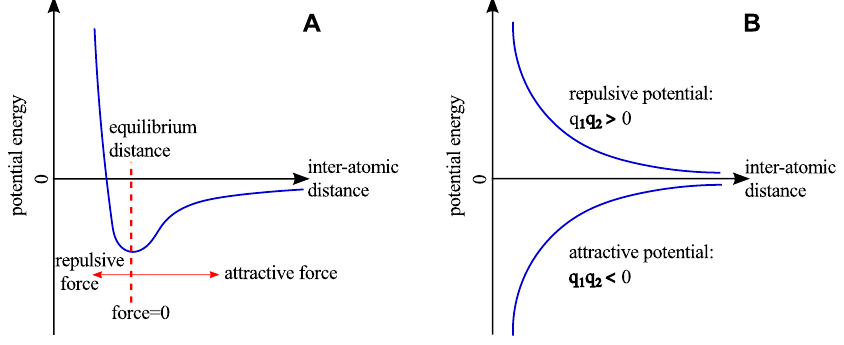
Figure 3. A schematic representation of the non-bonded interactions. ( A ) The Lennard-Jones potential shows the weak attraction and strong repulsion. ( B ) The Coulomb potential represents the interaction between two particles of same and opposite